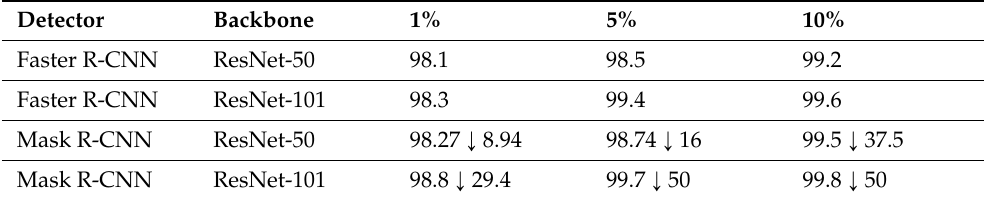
Table 1. Different supervised train detectors compared on floor-plan under the semi-supervised setting on Faster R-CNN [25] and Mask R-CNN [17] with ResNet-50 [19] and ResNet-101